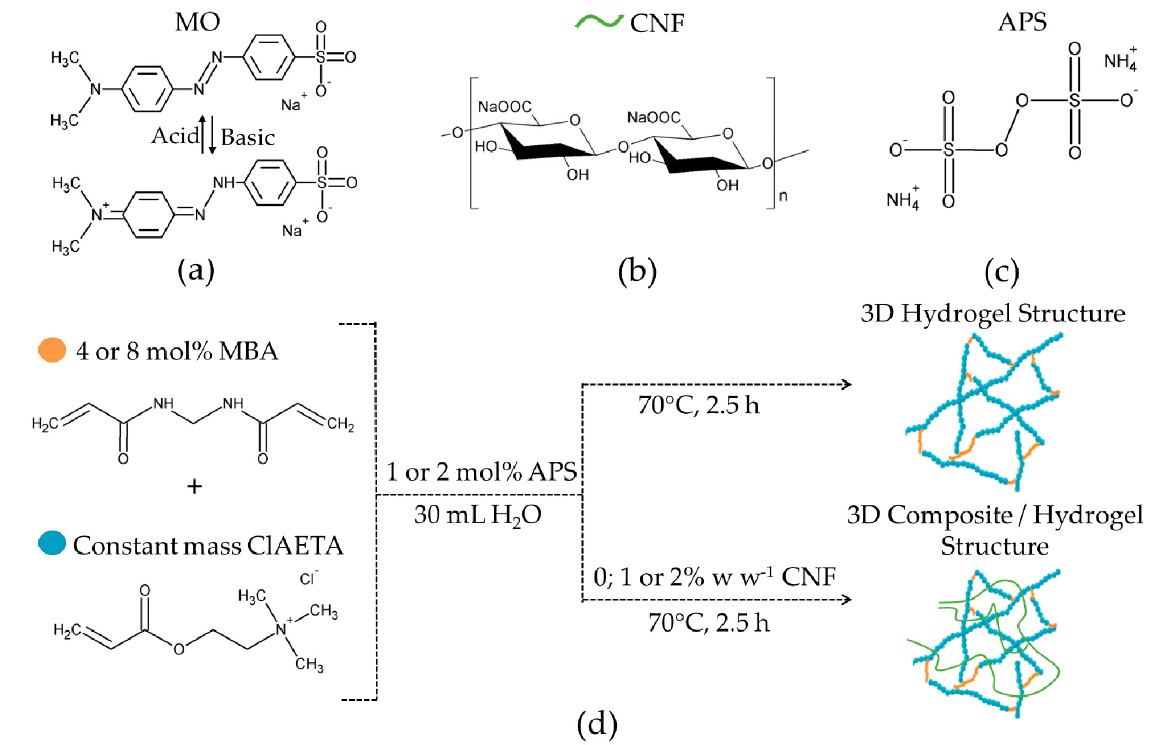
Figure 1. ( a ) Chemical structure of MO dye (molecular formula: C 14 H 14 N 3 O 3 SNa), ( b ) chemical structure of CNF, ( c ) chemical structure of poly(ClAETA), and ( d ) illustrative representation of the synthesis process of the exchange hydrogels obtained from this work.